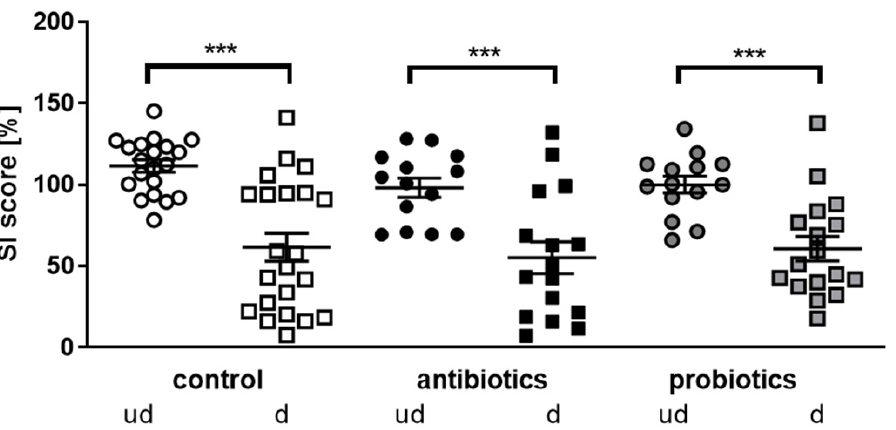
Figure 2. Social interaction of microbiome-manipulated male mice. Mice that underwent antibiotics or probiotics treatment or served as controls were either let undefeated (ud) or received defeat (d) during 10 consecutive days. One week after the CSDS, social interaction was assessed by presenting an unknown male CSD1 mouse. The SI score is calculated as the percentage time spent in the interaction zone around the Plexiglas cylinder containing the CD1 mouse divided by the time spent in the same zone during the habituation (plexiglas cylinder containing no other mouse). Statistics were performed using one-way ANOVA with Fisher’s LSD post-test (*** p < 0.001; n = 20, 22, 14, 16, 14, 17). Data are shown as mean + SEM.